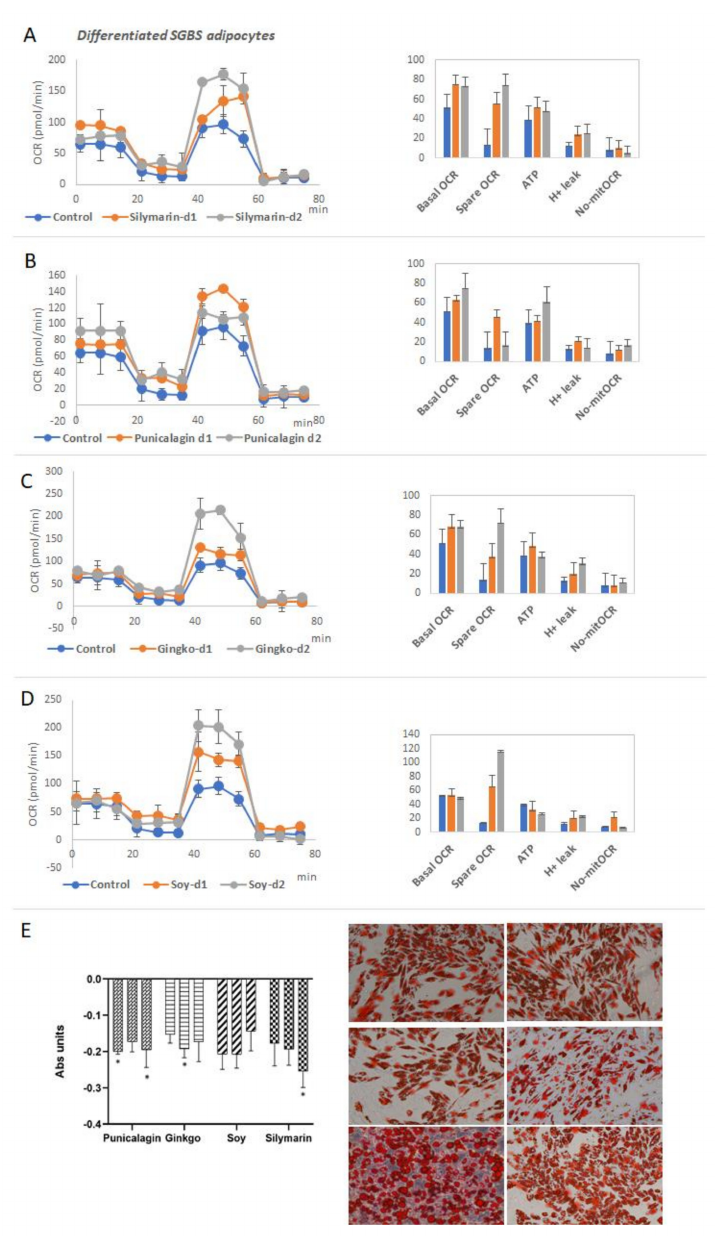
Figure 6. Effect of the extracts on mitochondrial oxidative phosphorylation of differentiated human adipocytes. ( A – D ) MitoStress profiles of the Oxygen Consumption Rate (OCR) after the sequential addition of modulators of the electron transport chain of differentiated adipocytes treated with different extracts (( A ) treated with Silymarin extract, ( B ) Punicalagin, ( C ) Ginkgo, and ( D ) Soy, respectively). Quantification of basal OCR, Spare respiratory capacity, ATP production linked to oxidative phosphorylation, H + leak and non-mitochondrial OCR. Asterisks indicate significant statistic differences * < 0.01. ( E ) Red Oil O staining and quantification after treatment with the extracts. Representative images of Red Oil staining to show lipid